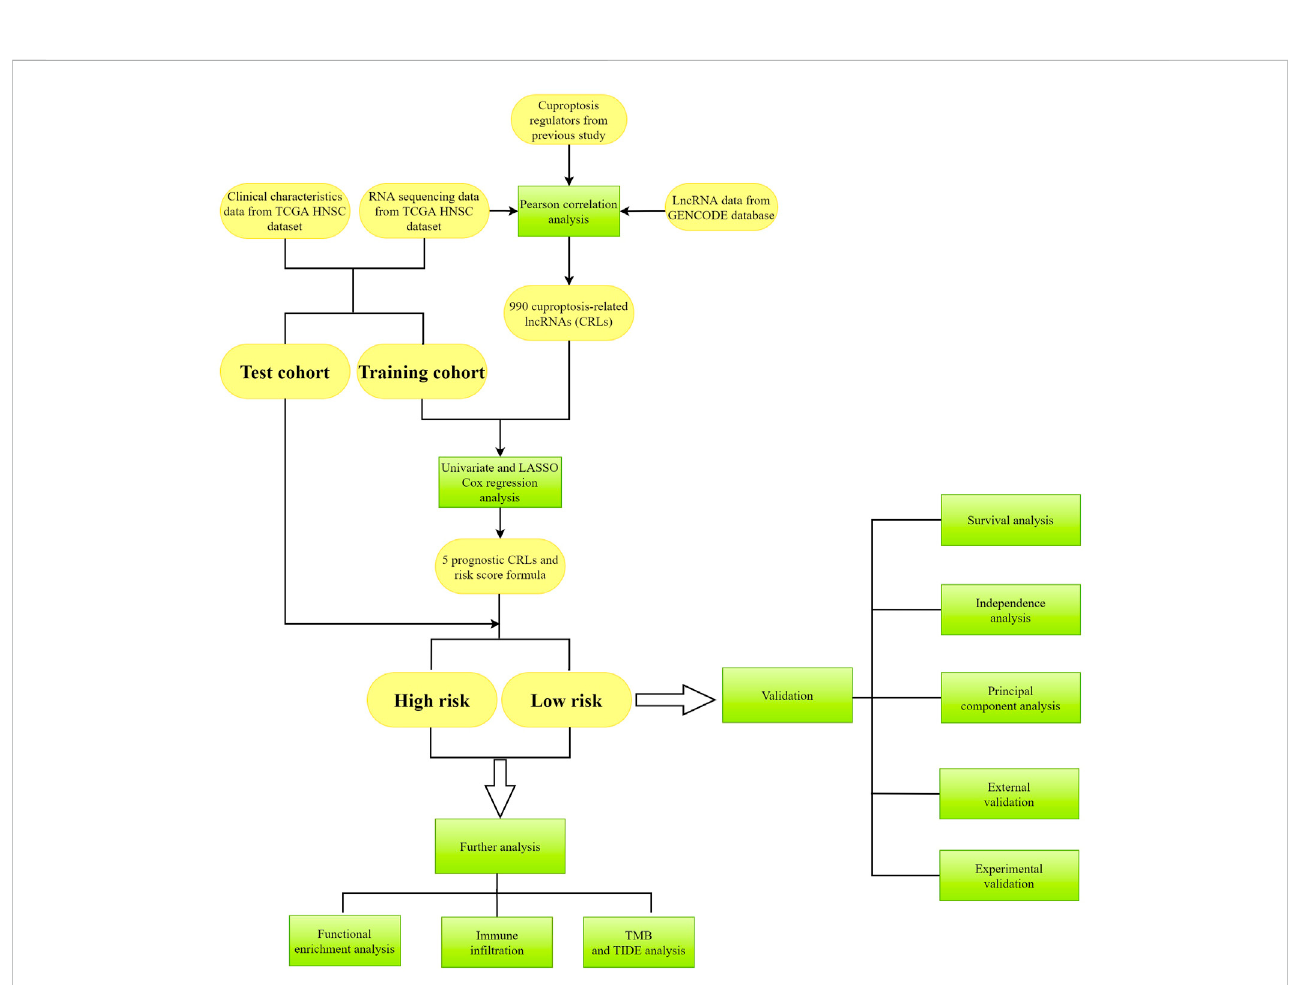
FIGURE 1 The fl owchart of analysis in this study. Yellow color represents the data, and green color represents the methods.